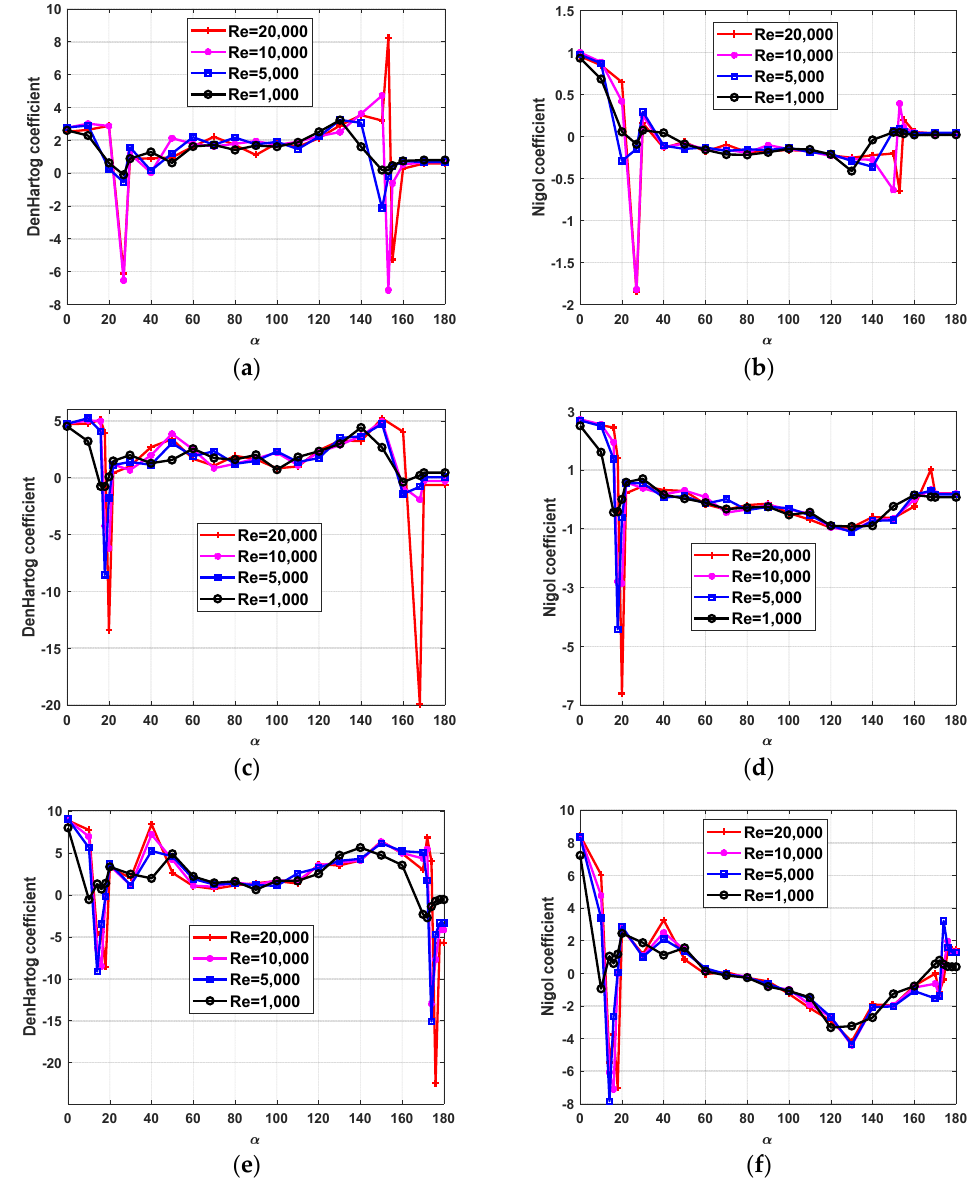
Figure 12. Den Hartog and Nigol coefficients of iced conductor with different icing thickness: ( a ) 0.25D-Den Hartog coefficient, ( b ) 0.25D-Nigol coefficient, ( c ) 0.5D-Den Hartog coefficient, ( d ) 0.5D- Nigol coefficient, ( e ) 1.0D-Den Hartog coefficient and ( f ) 1.0D-Nigol coefficient. Based on the Nigol mechanism, when the iced part is on the windward side, the un- Based on Den Hartog mechanism, when Re is 1000, the Den Hartog coefficients of